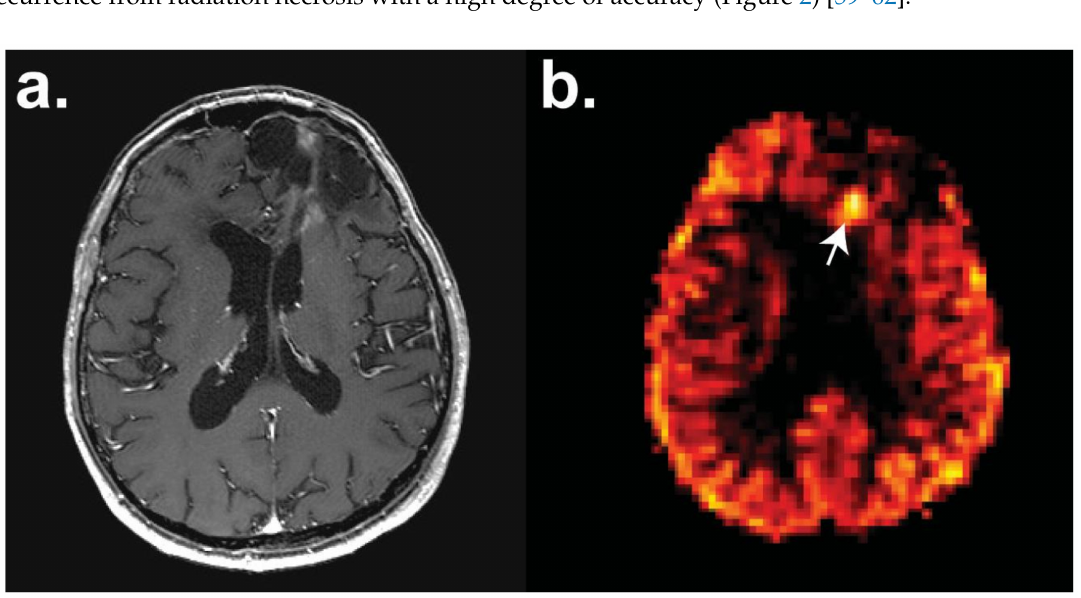
Figure 2. Perfusion magnetic resonance imaging (MRI) with pulsed arterial spin labelling (pASL) of a patient with a frontal high-grade oligodendroglioma with a focus of hyperperfusion (white arrow) identifying recurrent disease post-surgery and chemotherapy. Axial sections have the following sequences: ( a ) T 1 -weighted contrast-enhanced and ( b ) pASL. Images courtesy of Dr Harpreet